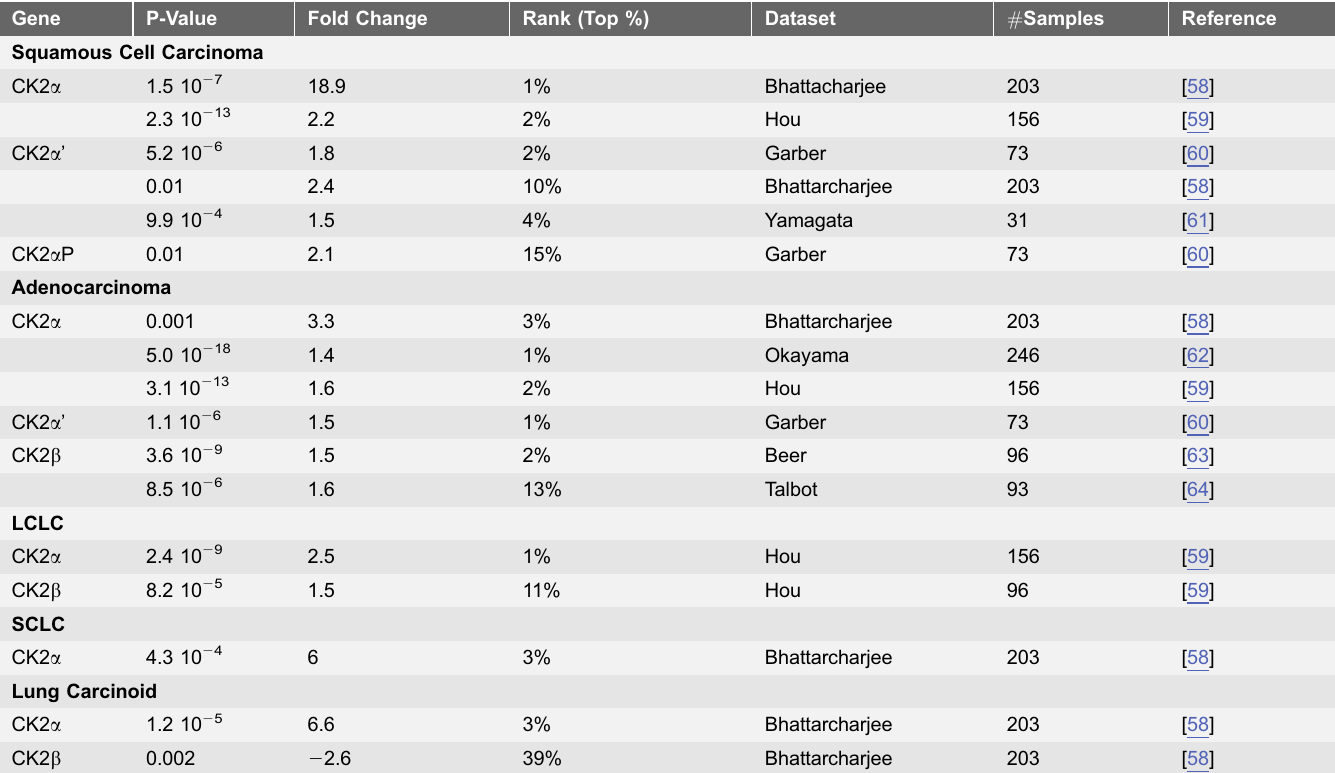
Different subtypes of lung cancer are analyzed and p-values, fold changes, and datasets are